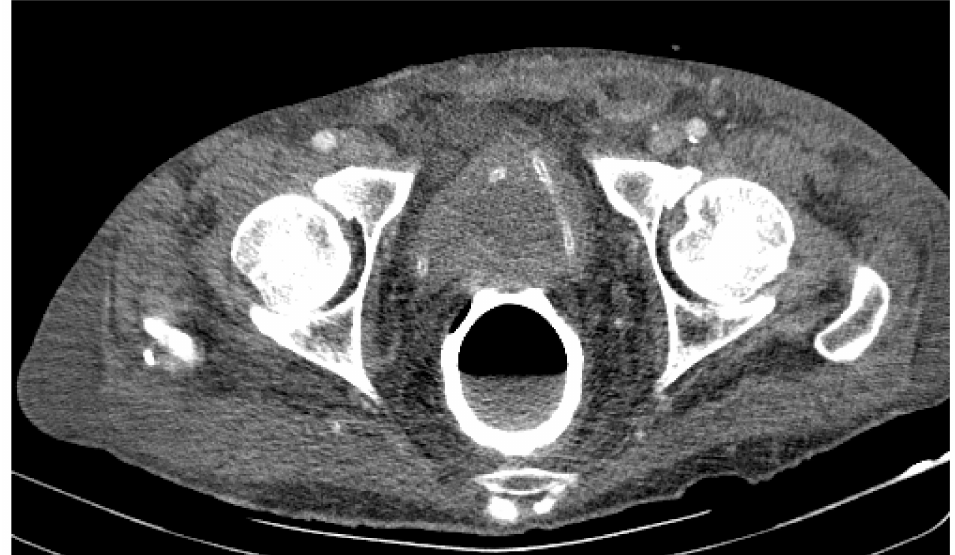
Figure 8. Patient’s computer tomography: the presence of a foreign body is highlighted, with regular edges and a maximum diameter of 65